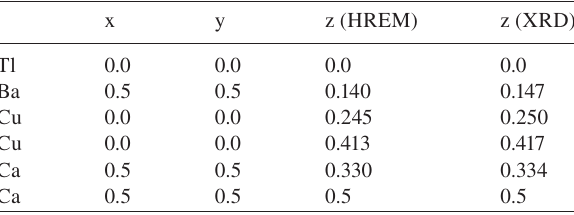
Table 1 Structural parameters of cations in TlBa measured from the HREM images and XRD [14].